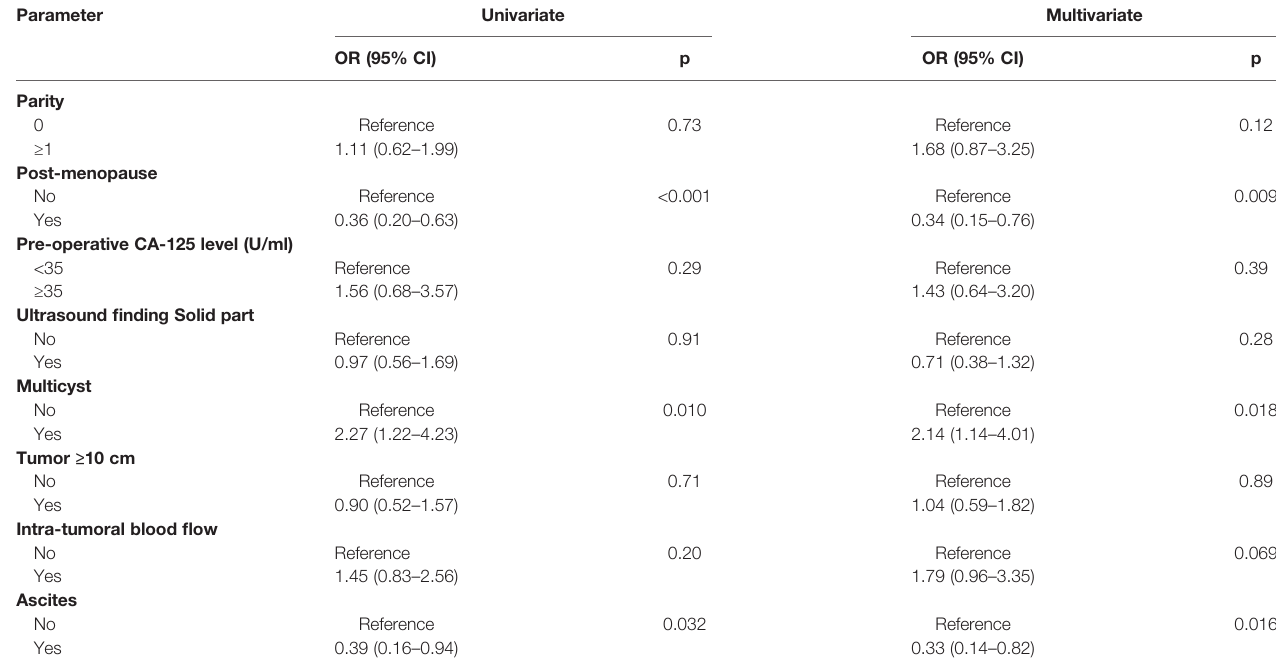
TABLE 6 | Logistic regression analysis of clinical factors for discordancy between intra-operative frozen and fi nal paraf fi n pathologies of 516 ovarian malignant tumors.